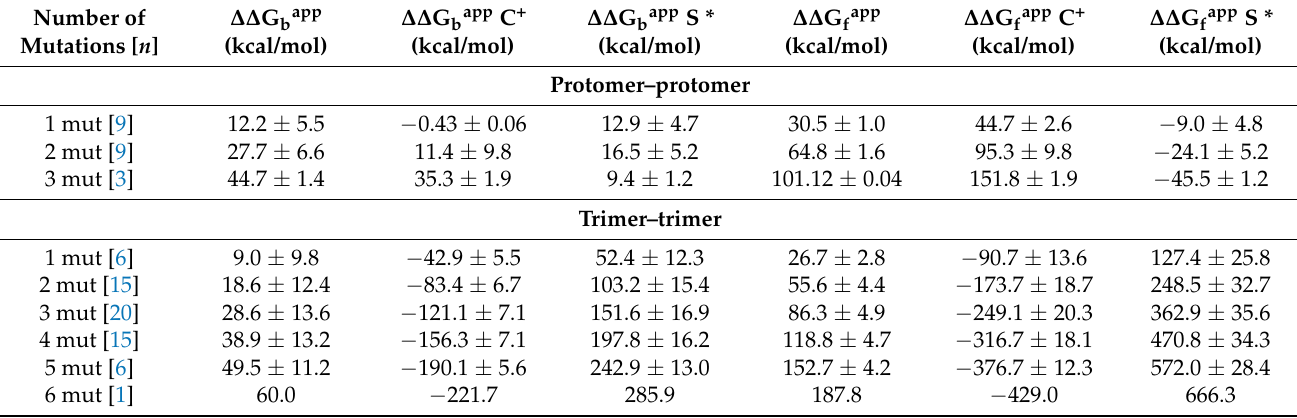
Table 3. Effects of the number of Q180E-mutated protomers on the relative affinity ( ∆∆ G bapp ) and stability ( ∆∆ G fapp ) of the globular heads constituted by three protomers (Protomer–protomer) and of the interaction between globular heads (Trimer–trimer). ∆∆ G values are reported as average ± standard deviation of [ n ] possible combinations of WT/mutant complexes.